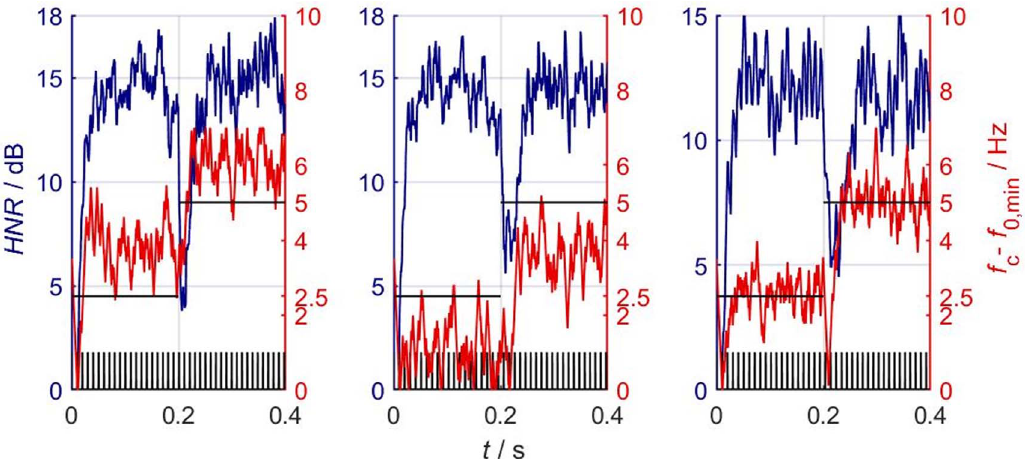
Figure 4. Complex tone with all harmonics mistuned by +6 Hz (left panel) and (cid:2) 6 Hz (center panel) at a SNR of 7.5 dB (Simulation II; same as center panel of Figure 3, but with mistuning). Data presentation is the same as in Figure 3. Mistuning does not affect PM- HLL functionality, but the fundamental frequency estimate is biased on average by +1.21 Hz and (cid:2) 1.39 Hz, respectively. Right panel: Data for a complex tone with missing fundamental (simulation III) shows a similar pattern as the corresponding case of a complex tone with the fundamental present (center panel of Fig. 3). The HNR drops by about 3.4 dB compared to the corresponding case, because the three lowest of in total fi ve harmonics were discarded from the